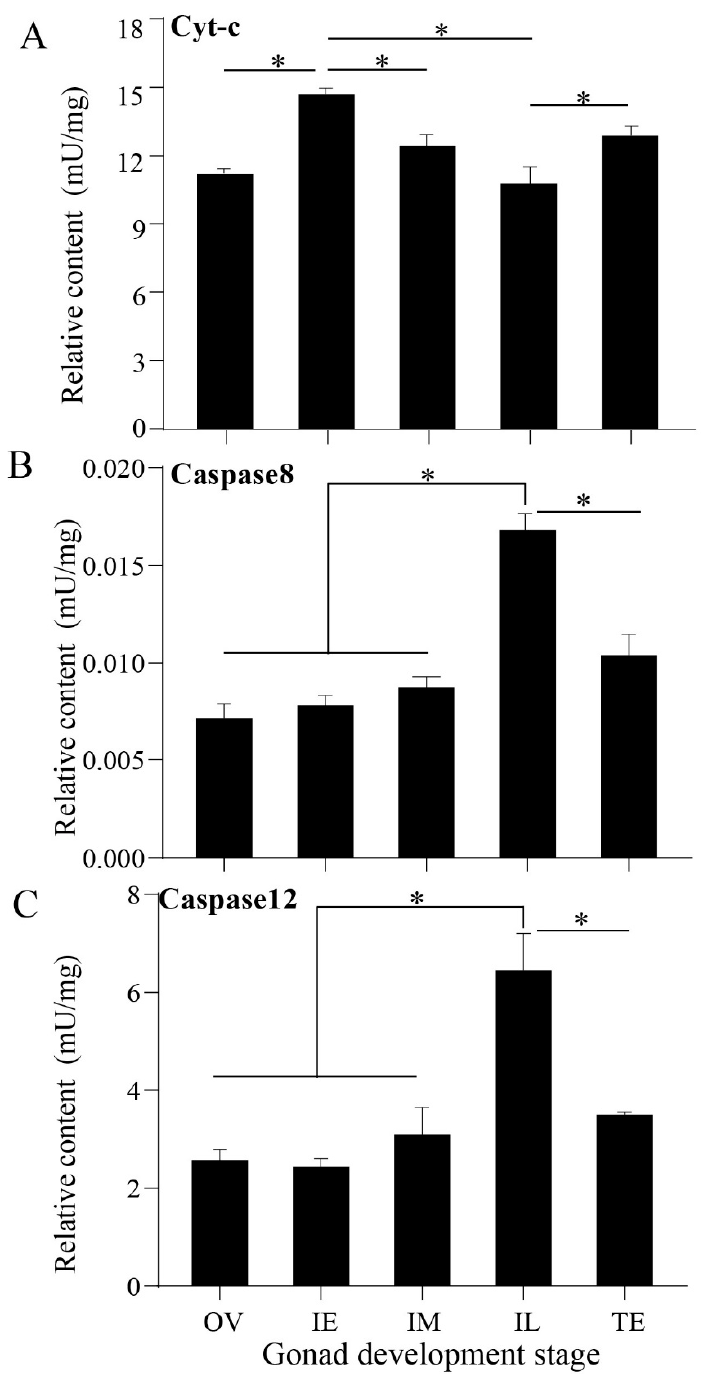
Figure 2. Expression patterns of apoptotic proteins related to the three signaling pathways during the gonadal development of Monopterus albus . ( A ), Expression patterns of cyt-c in the mitochondrial pathway; ( B ), Expression patterns of caspase-8 in the dead receptor pathway; ( C ), Expression patterns of caspase-12 in the ER pathway. OV, female stage ovary; IE, early intersexual stage ovary; IM, middle intersexual stage ovary; IL, late intersexual stage ovary; TE, testis. Asterisks (*) indicate significant differences between two groups ( p <